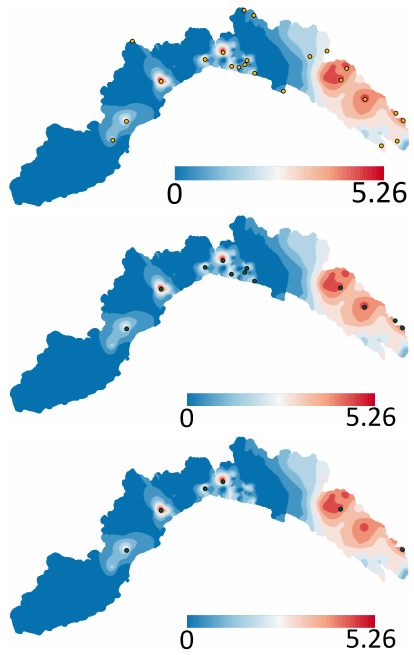
Figure 3: A function F : M → R , color-coded from blue (low) to red (high) values, and the associated local maxima hav- ing persistence greater than α (max F − min F ) , with α = 0 . 05 , 0.15 (middle) and